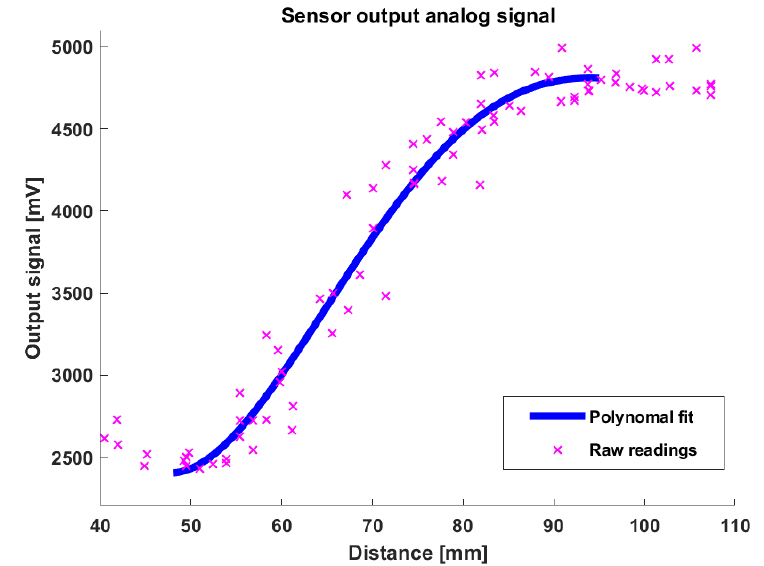
Figure 7. Distance measurement characteristics graph for the proposed